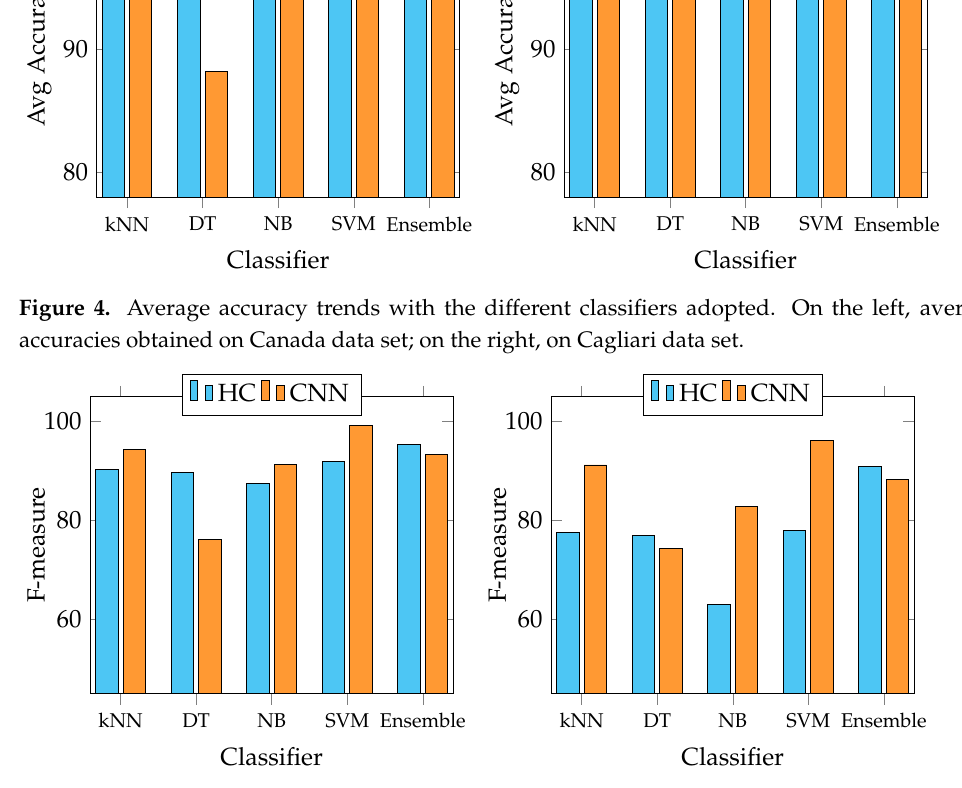
Figure 5. Best MFM trends with the different classifiers adopted. On the left, best MFM obtained on Canada data set; on the right, on Cagliari data set.